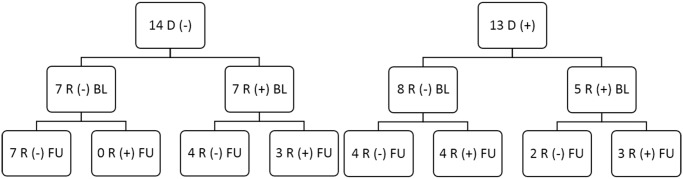
Classification of patients who survived more than 9 months after the transplantation at baseline (BL) and at Follow up (FU) according to their donor’s TcCRA serological status.